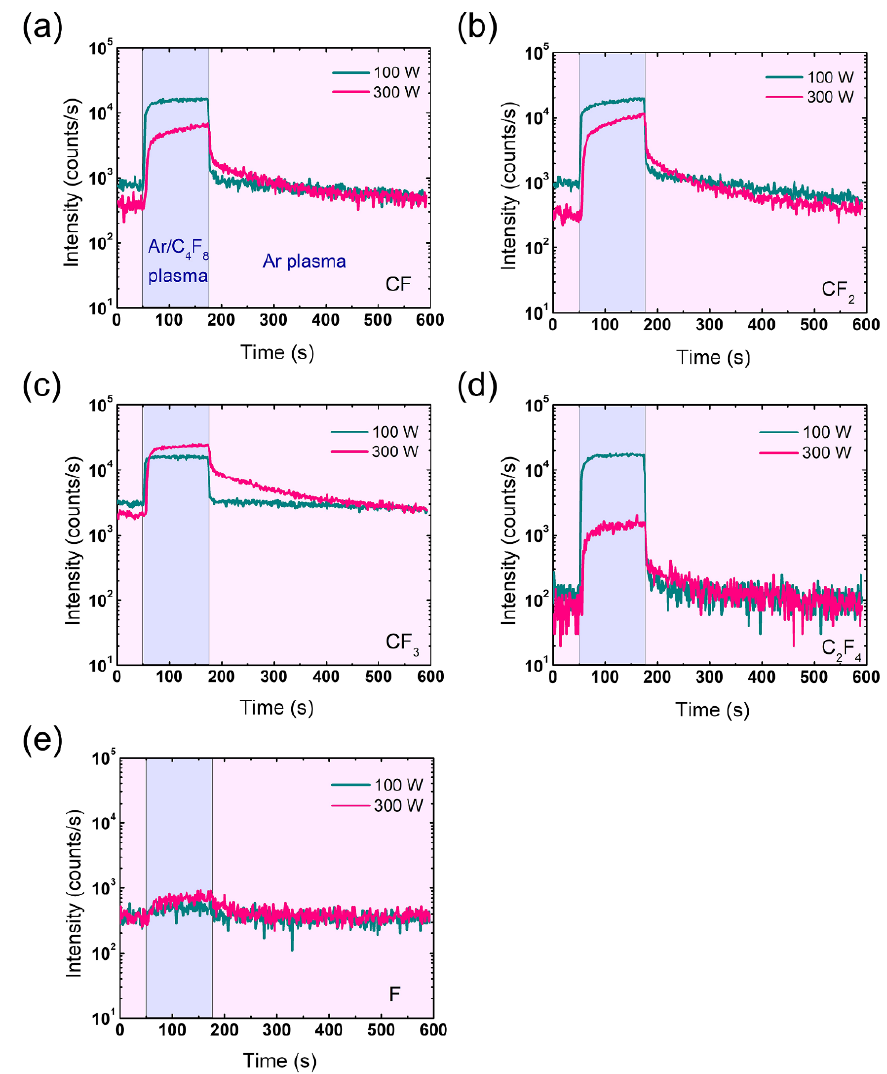
Figure 6. FC radical densities measured using a QMS during one cycle of ALE at 100 W and 300 W of ( a ) CF, ( b ) CF 2 , ( c ) CF 3 , ( d ) C 2 F 4 , and ( e ) F.